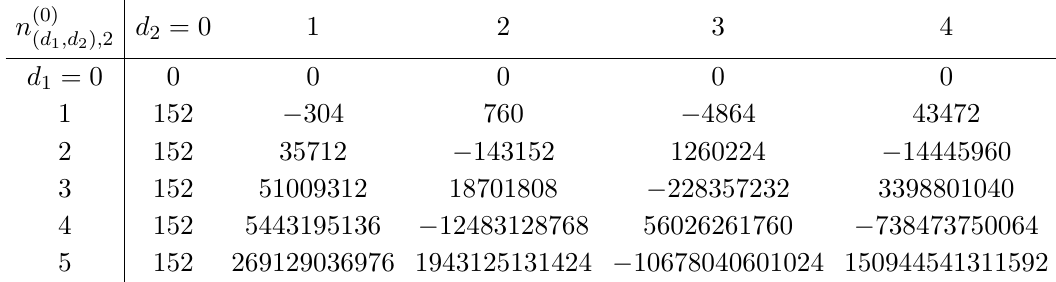
with Z charge 2 4 0